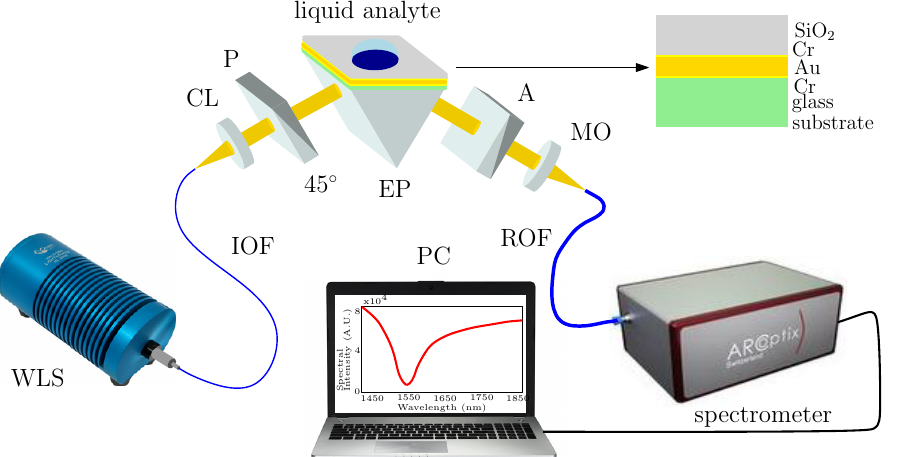
Figure 8. Schematic drawing of the experimental setup employing the SPR structure: white light source (WLS), input optical fiber (IOF), collimating lens (CL), polarizer (P), equilateral prism